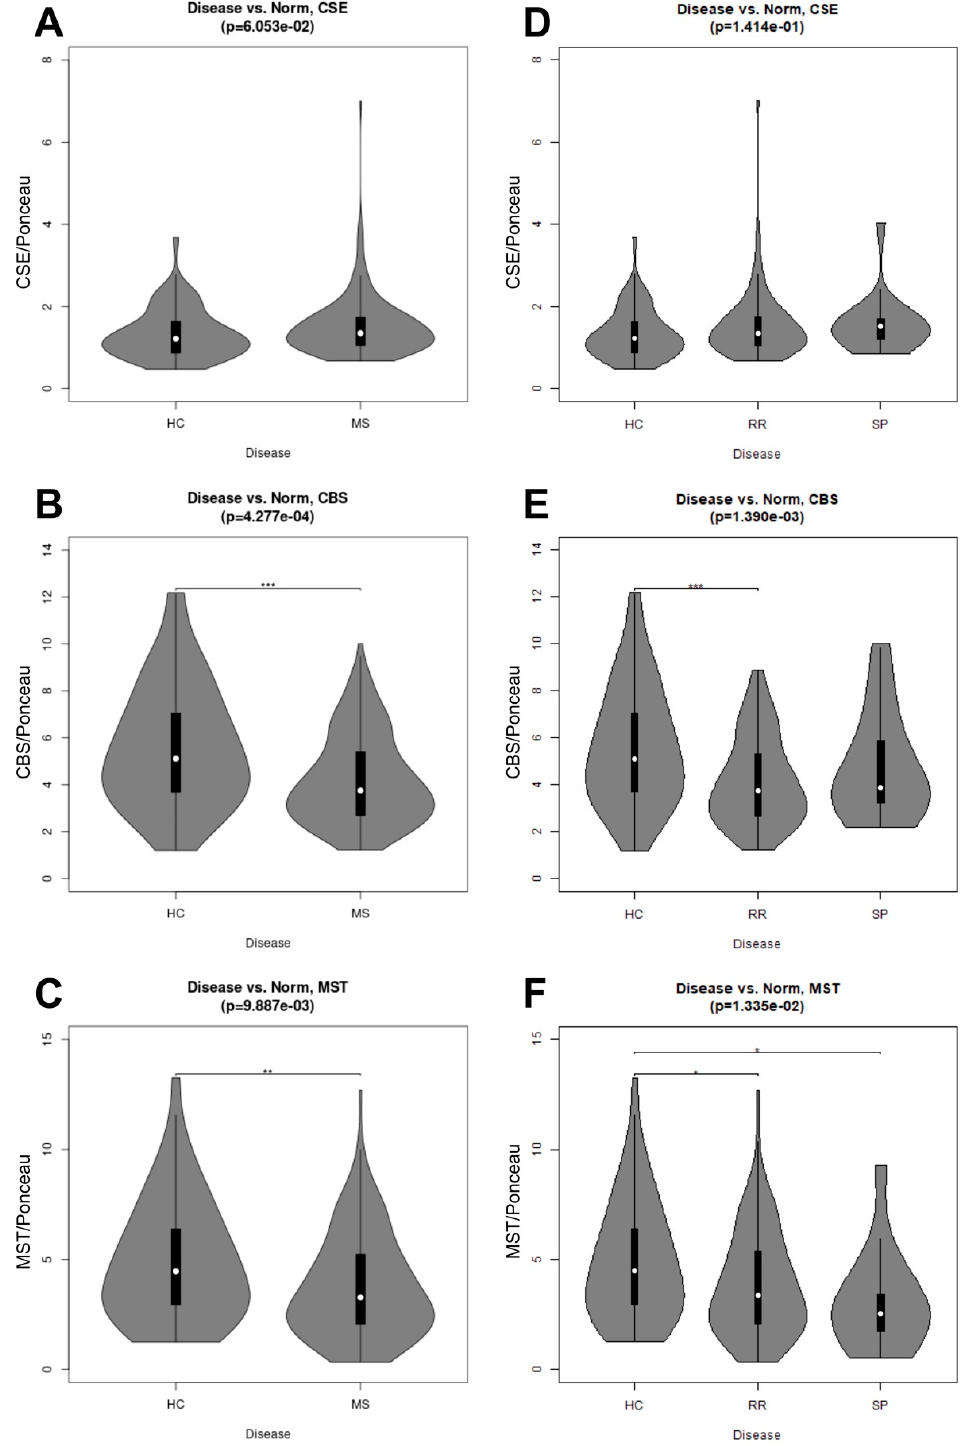
Figure 4. Serum blotting for CSE, CBS and MST in healthy controls (HC), in MS aggregate and MS subgroups (RRMS, SPMS). Violin Plots from Mann–Whitney U and Kruskal–Wallis Tests. Plots display the enzymatic changes of CSE (TOP ROW), CBS (MIDDLE ROW), and MST (BOTTOM ROW) in HC and condensed datasets (MS) (LEFT COLUMN), and HC and uncondensed datasets (RRMS vs. SPMS) (RIGHT COLUMN). Serum samples include 50 HC, 152 MS, 137 RRMS, and 15 SPMS. The white dot represents the median, while the box constitutes the interquartile range. ( A ) CSE in HC vs. MS; ( B ) CBS in HC vs. MS; ( C ) MST in HC vs. MS; ( D ) CSE in HC vs. RRMS and SPMS; ( E ) CBS in HC vs. RRMS and SPMS; ( F ) MST in HC vs. RRMS and